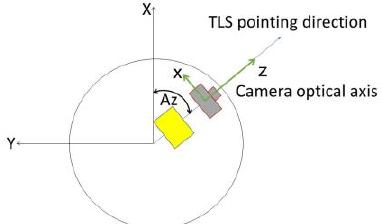
Figure 1. Relation between TLS coordinate system and virtual camera coordinate